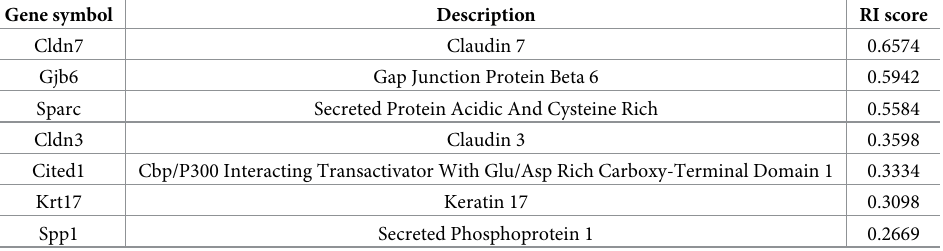
Table 3. Important discriminative genes for distinguishing mammary epithelia